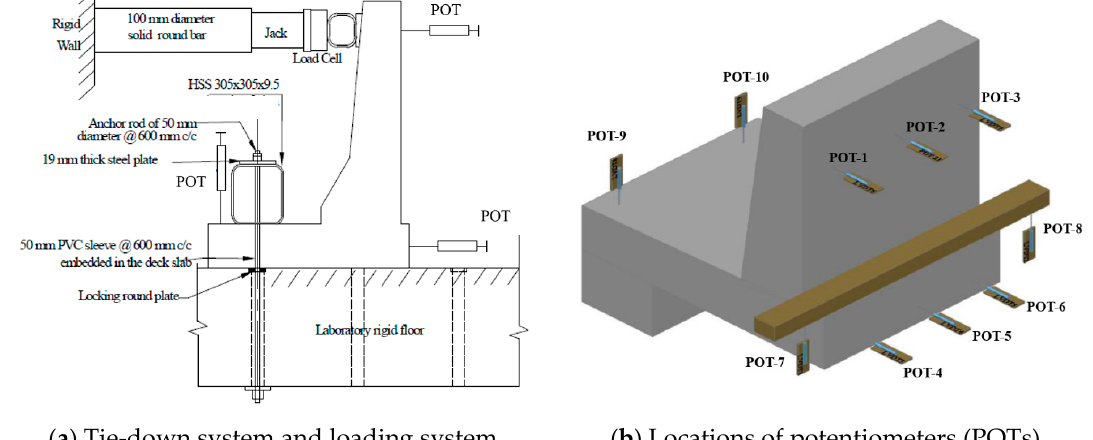
Figure 9. Test setup. ( a ) Tie-down system and loading system; ( b ) locations of potentiometers (POTs).